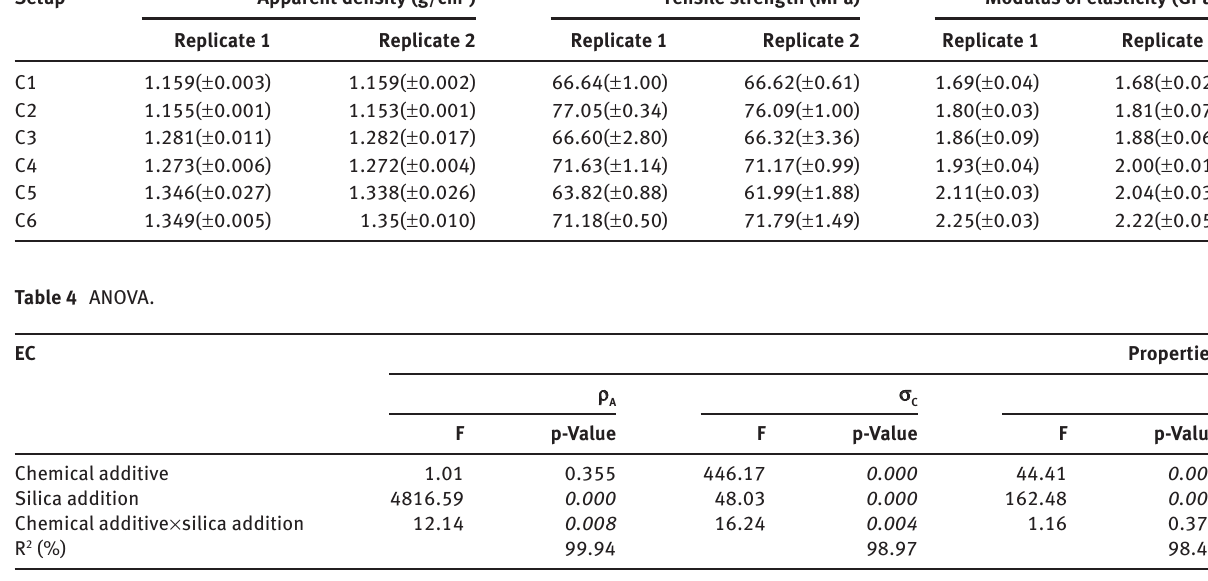
Figure 1 Compressive specimens for the setup conditions. Table 3 Experimental data (mean and standard deviation). Setup